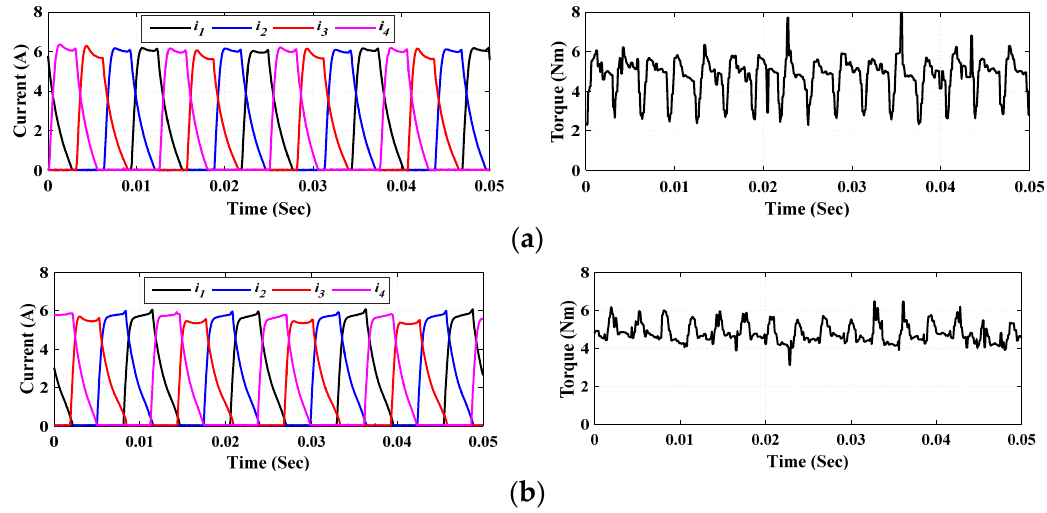
Figure 16. The experimental results at 806 r/min for: ( a ) conventional ATC; ( b ) Proposed SATC.